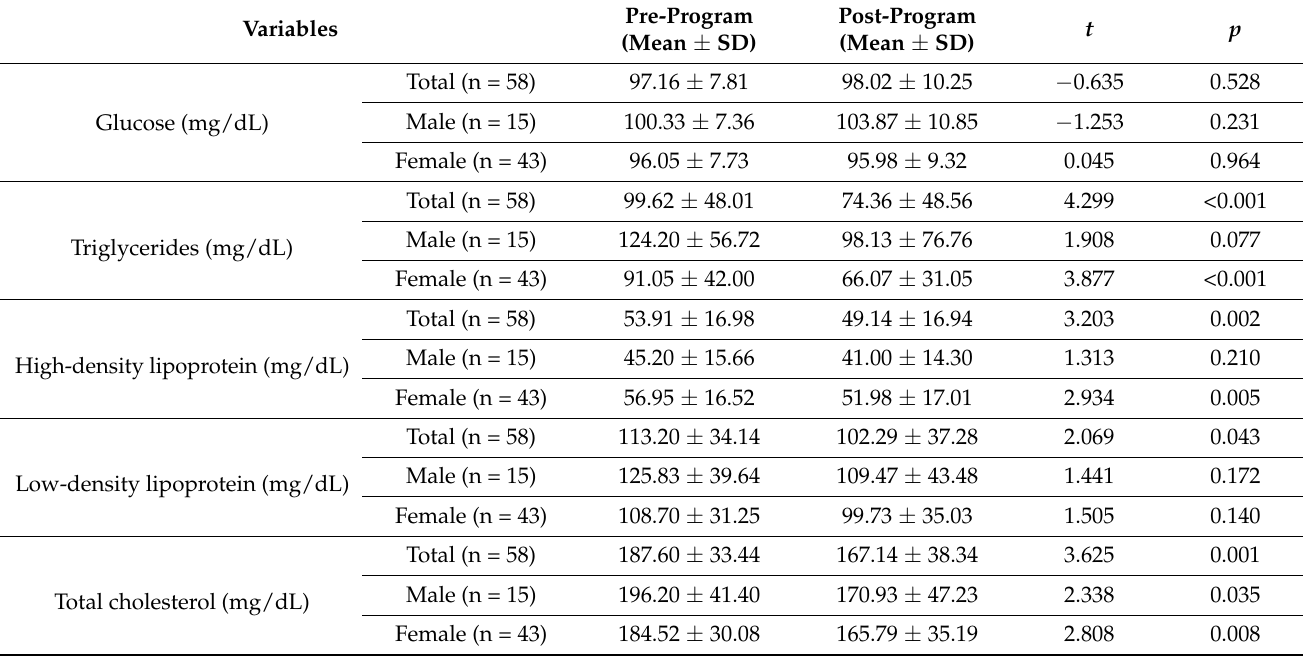
Table 6. Changes in blood profile variables after 24 weeks of non-face-to-face